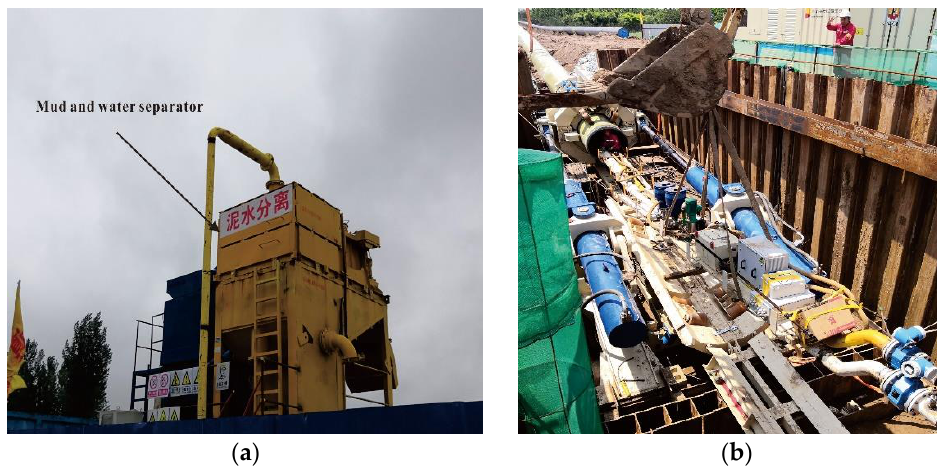
Figure 11. The project mud–water separation equipment and installed pump: ( a ) mud–water separa- tion equipment; ( b ) installed